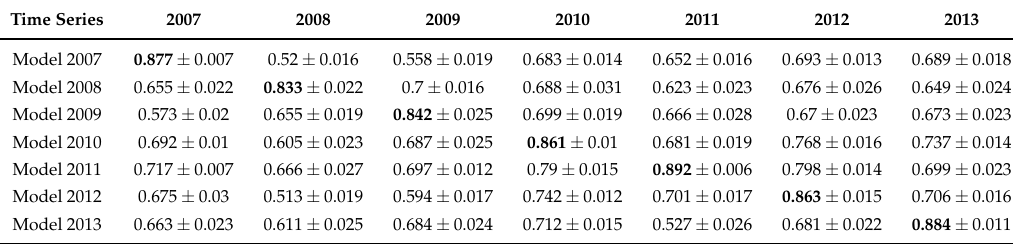
Table 2. Overall accuracy obtained by the baseline cases. The rows represent the year of the data used to train the classifier, and the columns represent the year of the time series used to produce the map. On the diagonal, the standard supervised case is represented. The OA values and the confidence interval are computed using 10 different runs.